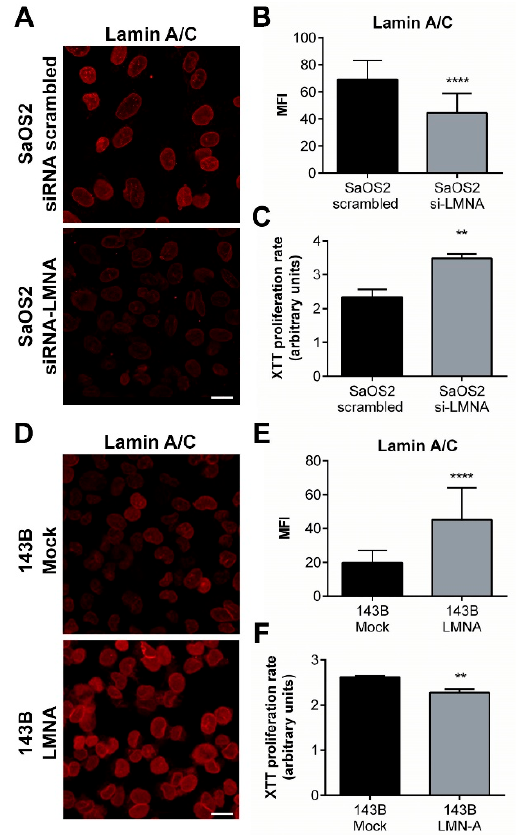
Figure 8. Modulation of LMNA gene expression in osteosarcoma cells. ( A ) Representative confocal images showing the di ff erential expression of lamin A / C in SaOS2 cells treated with a scrambled siRNA (SaOS2 siRNA scrambled) and with a siRNA against LMNA gene (SaOS2 siRNA-LMNA). Bar: 30 µ m. ( B ) Mean Fluorescence Intensity (MFI) of lamin A / C in siRNA scrambled vs. siRNA-LMNA SaOS2 cells. **** p < 0.001. ( C ) XTT proliferation assay performed on SaOS2 cells treated with siRNA scrambled and siRNA-LMNA for 72 h. ** p < 0.01. ( D ) Representative confocal images showing the di ff erential expression of lamin A / C in 143B cells transfected with an empty vector (143B Mock) and with a plasmid conveying LMNA gene (143B LMNA). Bar: 30 µ m. ( E ) Mean Fluorescence Intensity (MFI) of lamin A / C in Mock vs. LMNA 143B cells. **** p < 0.001. ( F ) XTT proliferation assay performed on 143B cells transfected with empty vector and LMNA-plasmid. ** p <